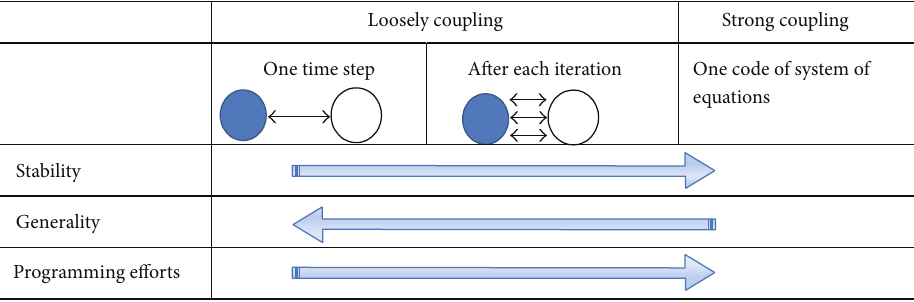
Figure 4: Comparing between loosely and strongly coupling algorithms